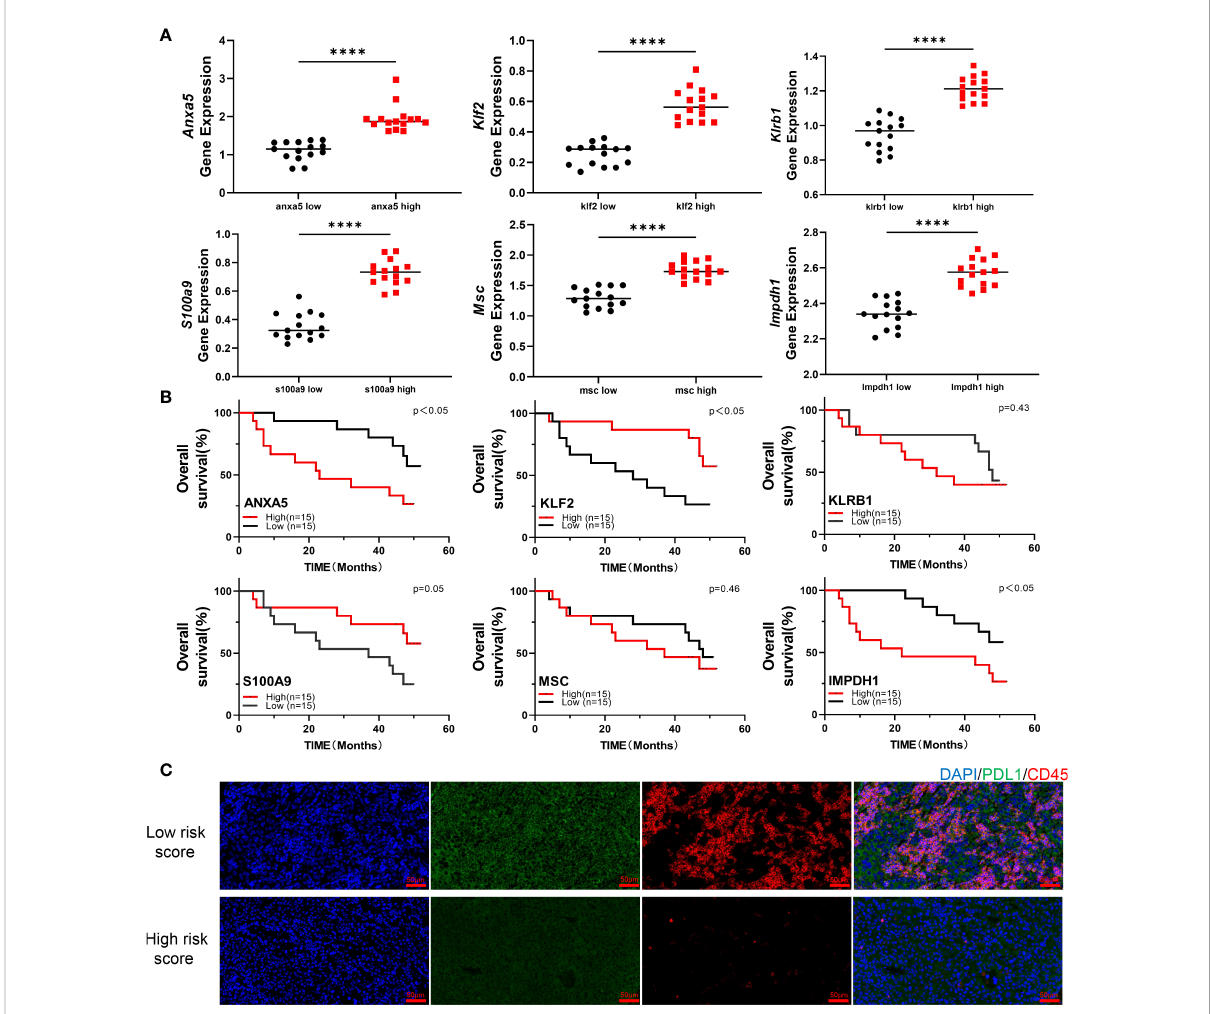
FIGURE 8 Experimental validation of the prognostic model on the basis of HCC patient samples (A) . Dot plots show the expressing level of six prognosis- related genes in HCC patient samples, as measured by qPCR experiments. (B) . According to the median expression of qPCR data, the 30 patients were categorized into two groups, and a survival curve was created based on survival time. (C) . Immuno fl uorescence staining showed the expression of CD45 and PDL1 in two groups of HCC tissue samples; the two groups of samples were the specimens with low risk score and the specimens with high risk score, respectively (****p <